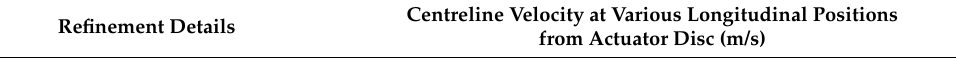
Table 3. Grid dependency